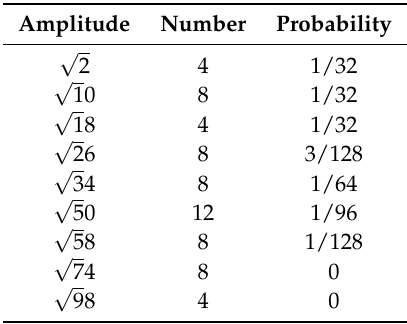
Figure 2. AM/AM and AM/PM conversions of 64-QAM equiprobable constellation at different input back off (IBO) values. Table 1. Probability of signal points with different